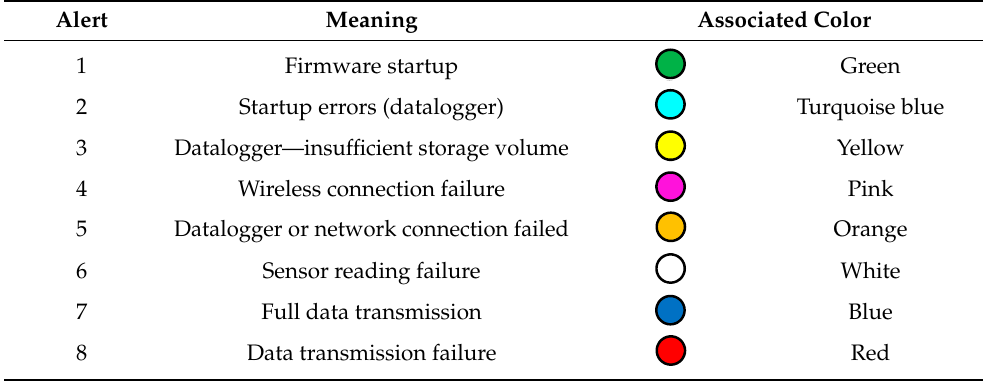
Table 2. Identification of alerts issued.